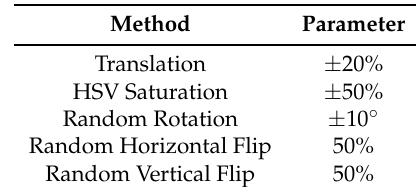
Table 1. The parameters of data augmentation.